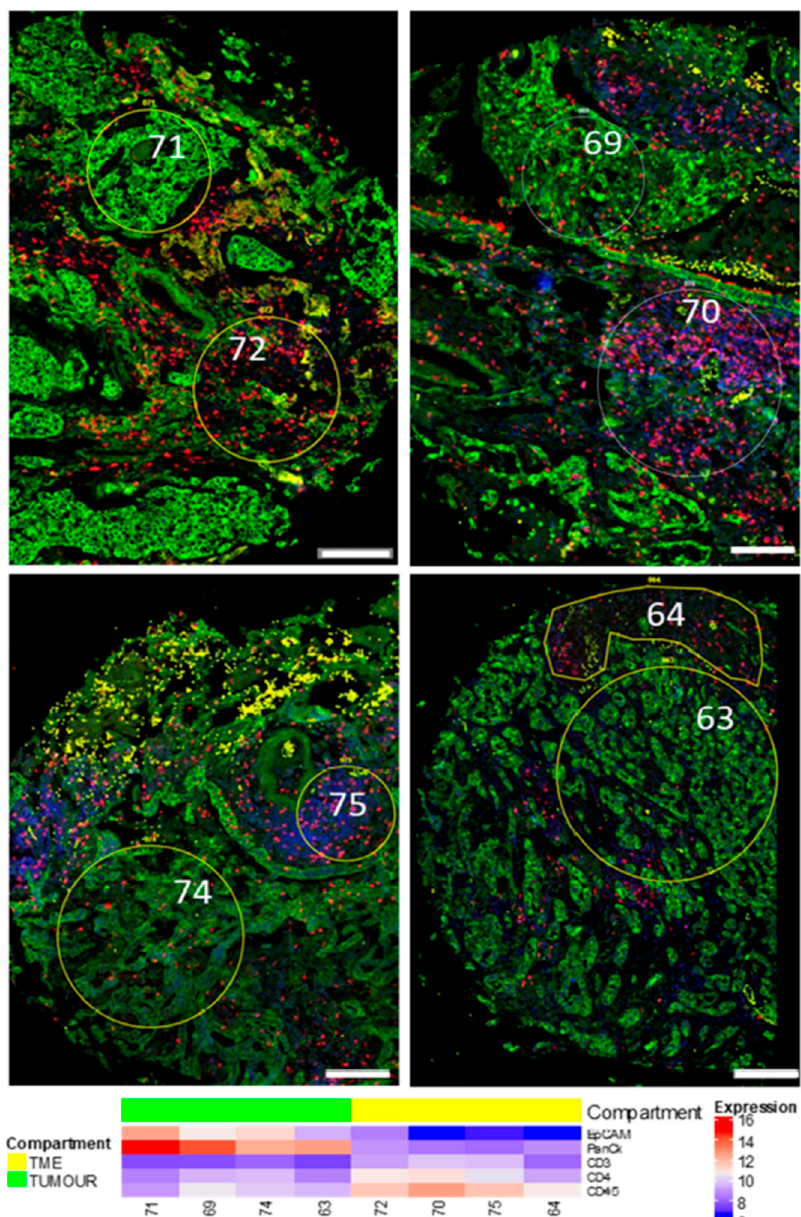
Figure 2. Tumour and immune ROIs exhibit distinct tumour/leukocyte marker expression. PanCK (Green), CD3 (Red), CD45 (Yellow), and DAPI (Blue). Representative paired tumour and immune ROIs are shown with corresponding Log2 expression of EpCAM, PanCK, CD3, CD4, and CD45. ROIs 71, 69, 74, and 63 represent tumour regions, while 72, 69, 74, and 63 are respective immune regions from corresponding patients. Scale bar = 200 µm.